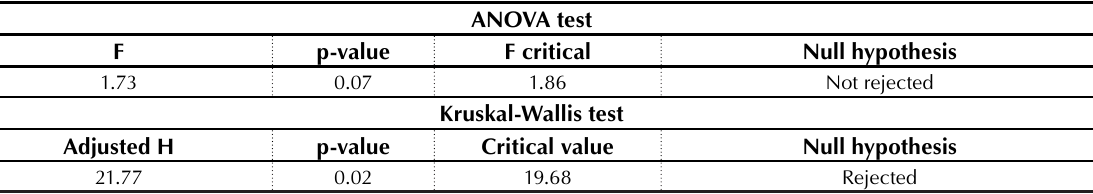
Table 2. Results of ANOVA and non-parametric Kruskal-Wallis tests for statistical differences in the frequency of overreactions between different